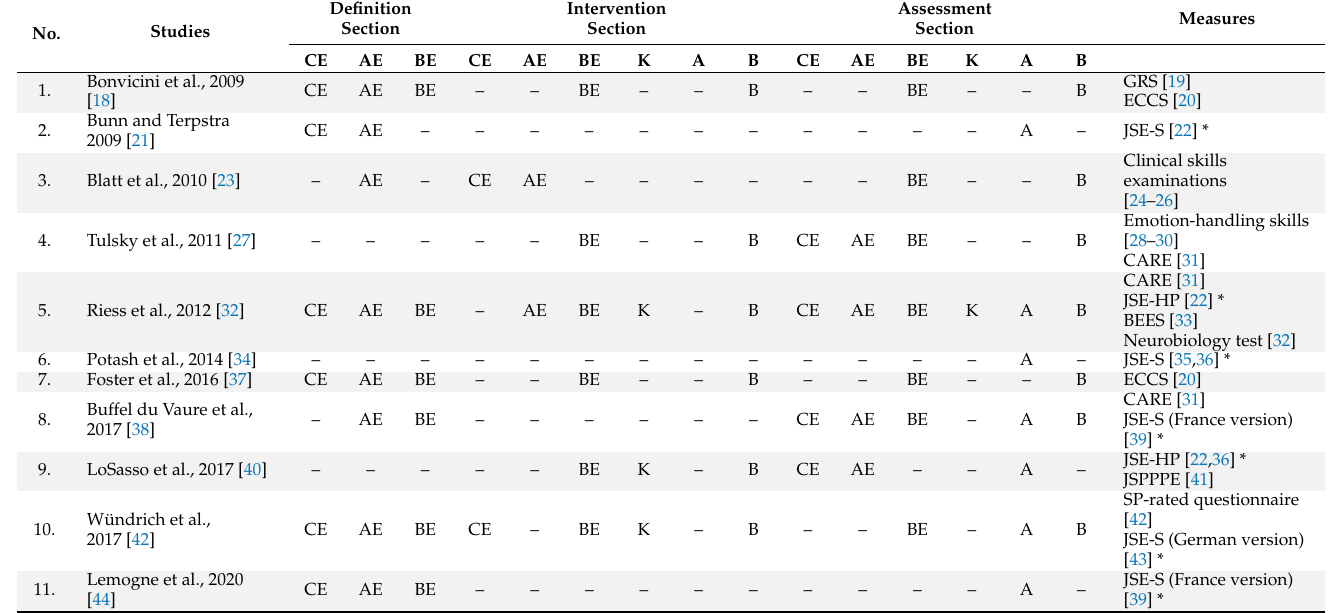
Table 1. Compositions of empathy dimensions and knowledge–attitude–behavior (KAB) aspects among different sections of the medical empathy intervention studies ( N =